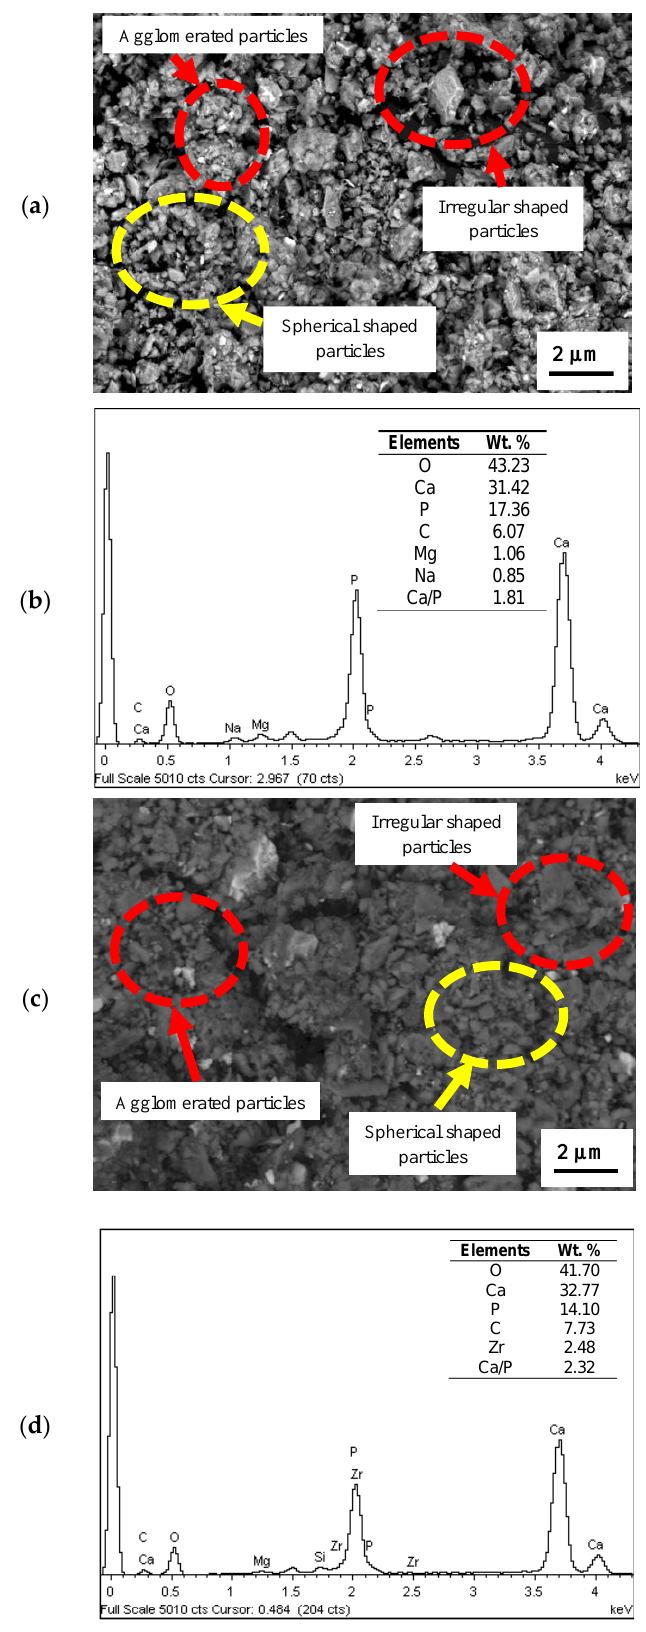
Figure 5. SEM micrographs of ( a ) FsHA + 0 wt.% YSZ powder, ( b ) EDX of FsHA powder, and ( c ) FsHA + 20 wt.% YSZ powder. ( d ) EDX of FsHA + 20 wt.% YSZ.